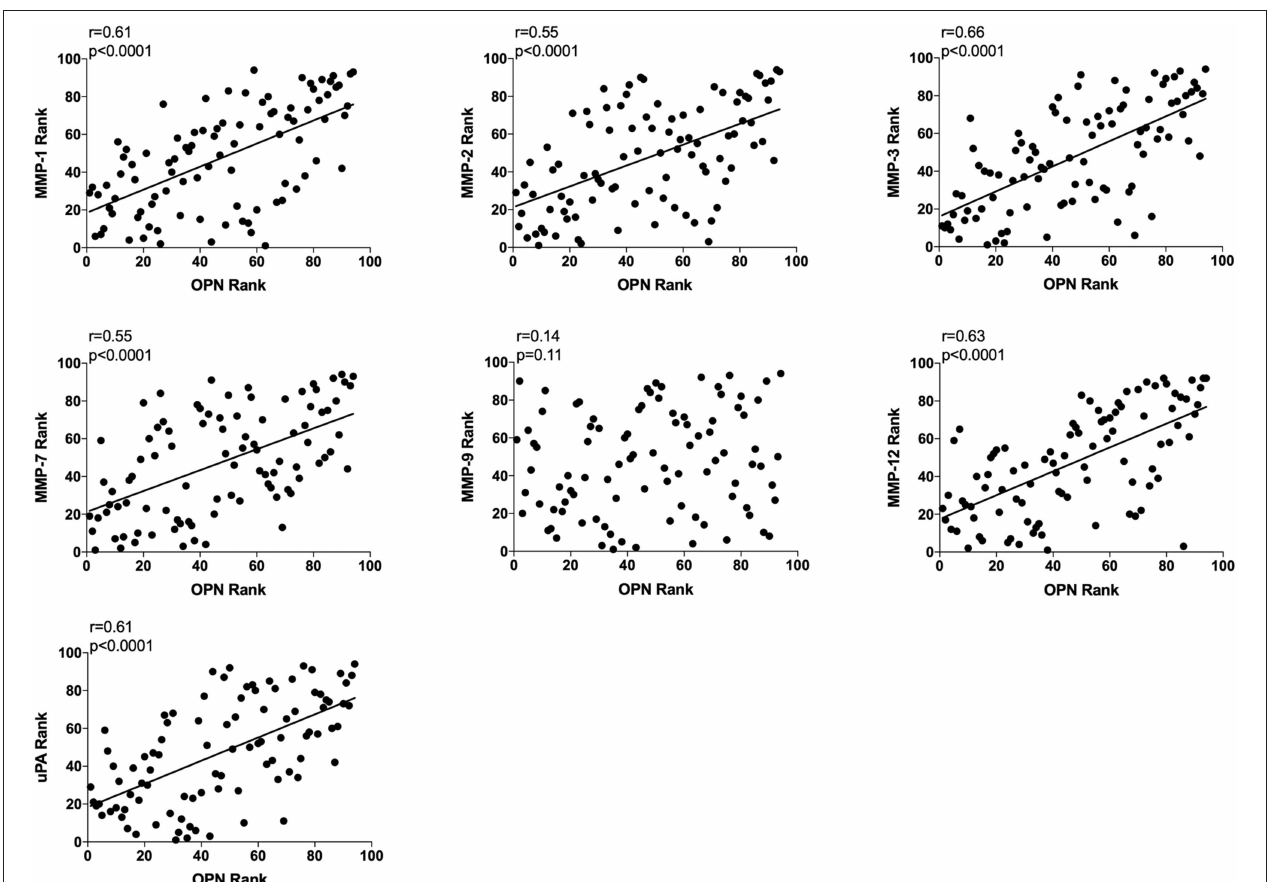
FIGURE 2 | Extracellular breast Osteopontin (OPN) levels in vivo and its correlations with extracellular protease levels in vivo in normal human breast tissue. Microdialysis was used to sample in vivo extracellular molecules from breast tissue of women. Proteins were quantified using a multiplex proximity extension assay as described in the materials and methods section. A total of 94 microdialysis investigations of normal breast tissue unexposed to any treatment is depicted; 42 post-menopausal healthy volunteer women, attending the regular mammography-screening program; 21 post-menopausal women treated for early breast cancer investigated in their unaffected normal breast before the start of adjuvant tamoxifen therapy; 13 post-menopausal healthy volunteer women before the start of dietary flaxseed addition; 10 premenopausal healthy volunteer women before the start of dietary flaxseed addition; and four premenopausal women in two consecutive luteal phases of the menstrual cycle. Statistics were calculated using Pearson’s correlations coefficient on ranked